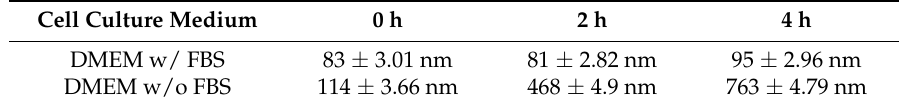
Table 1. Hydrodynamic diameter of clg-AuNPs dispersed in DMEM w/ and w/o FBS at three different time points. Mean value and standard deviation of three measurements per condition are reported.